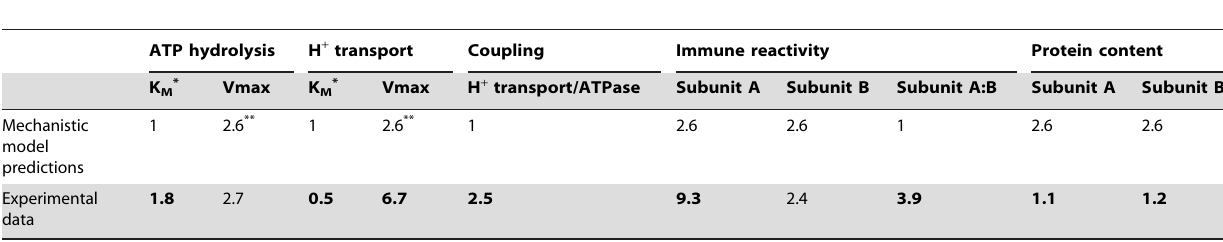
Table 1. Changes in different characteristics of the yeast V H + - ATPase by extracellular glucose according to the current mechanistic model and experimental data of this